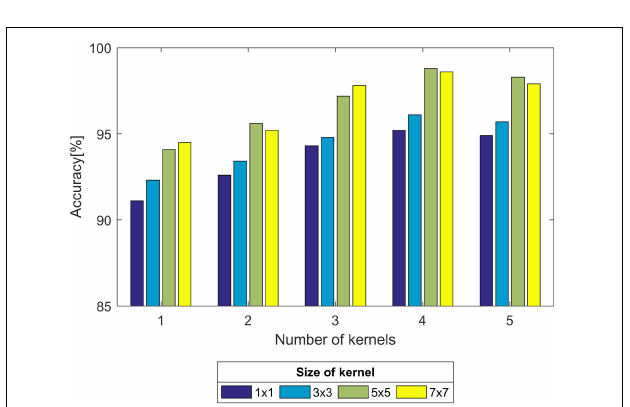
FIGURE 6 | Change in accuracy (top, A ) and loss (bottom, B ) during the training and validation processes (Note: 1 epoch = 500 iterations and the validation process is carried out for each epoch).